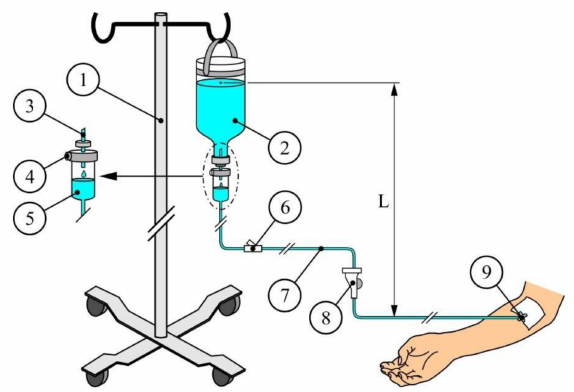
Figure 1. Traditional intravenous (IV) infusion therapy set: 1—pole/stand, 2—IV bottle/bag, 3—spike, 4—air valve, 5—drip chamber, 6—piggyback port, 7—IV tubing, 8—roller clamp, and